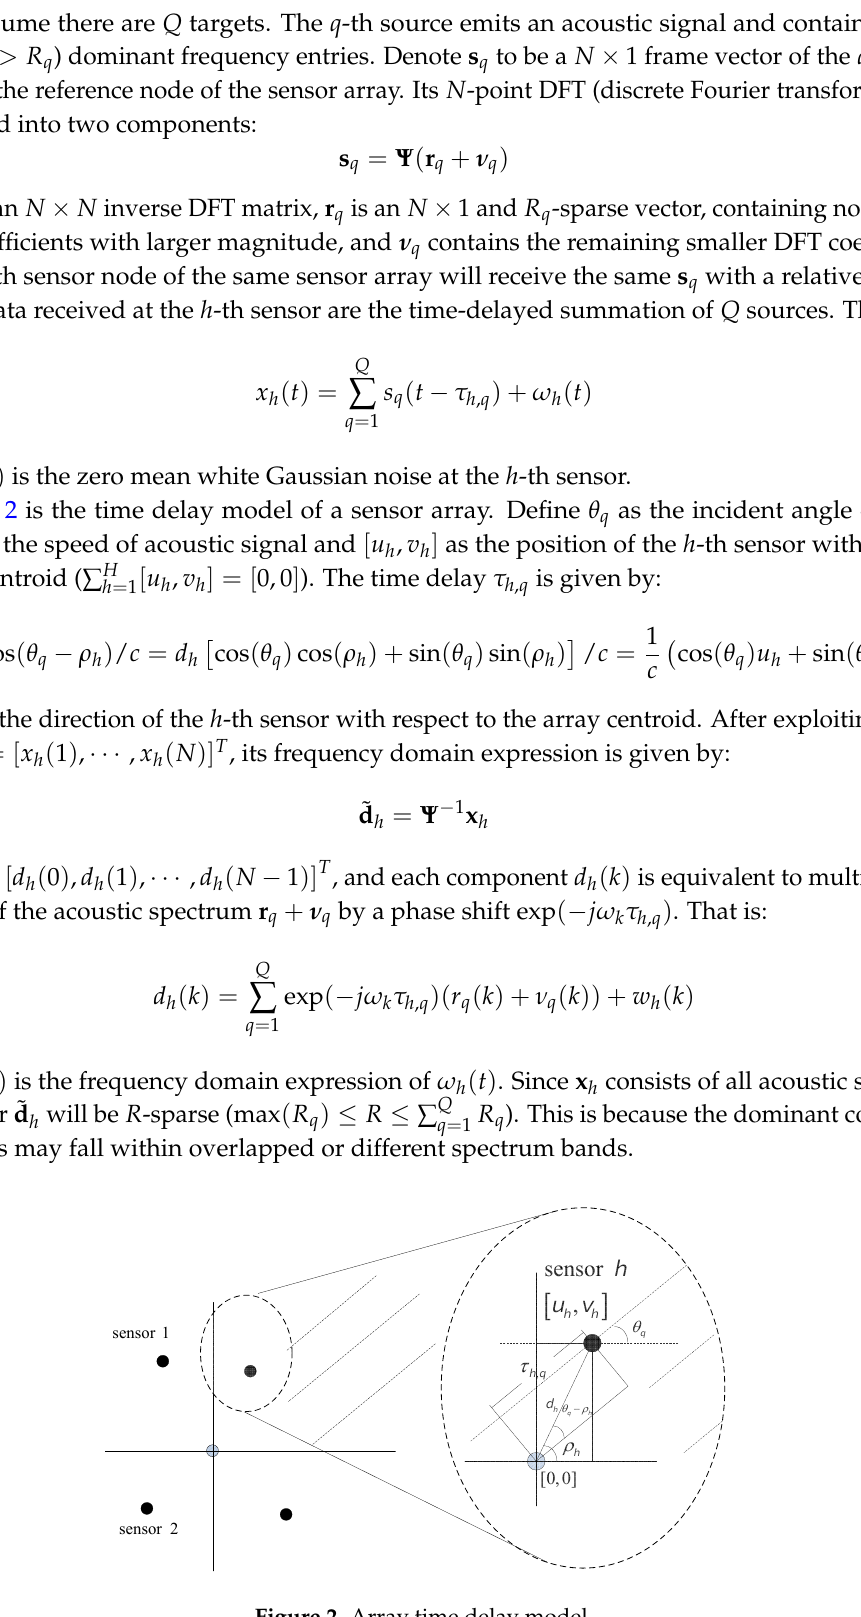
Figure 2. Array time delay